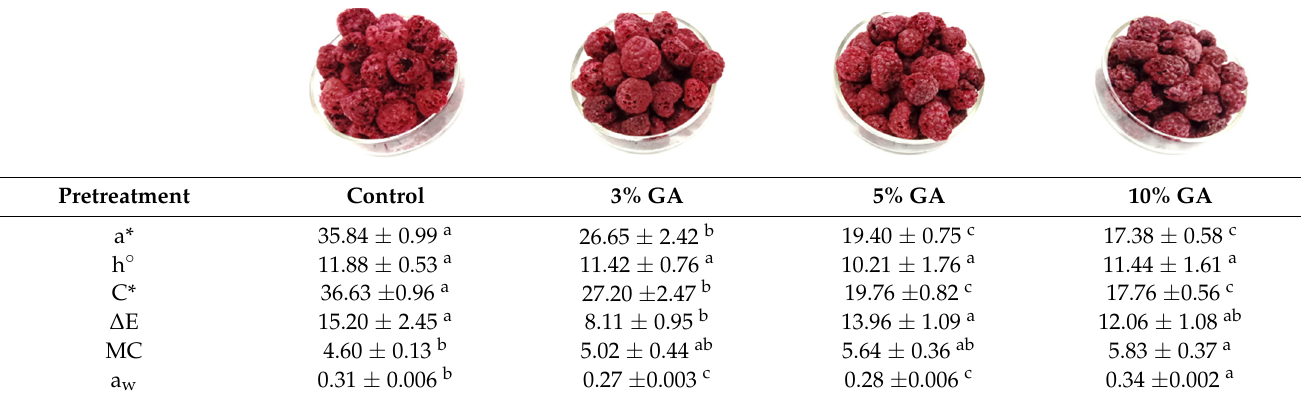
0.34 ± 0.002 a Values represent the mean ± SE ( n = 3). Values in a row with different superscripts indicate a significant difference ( p < 0.05) according to Duncan’s multiple range test. GA = gum arabic; MC = moisture content; a* = redness; h ◦ = hue angle; C* = chroma; ∆ E = total colour difference; a w = water activity. Control samples were dipped in distilled water for 2 min.